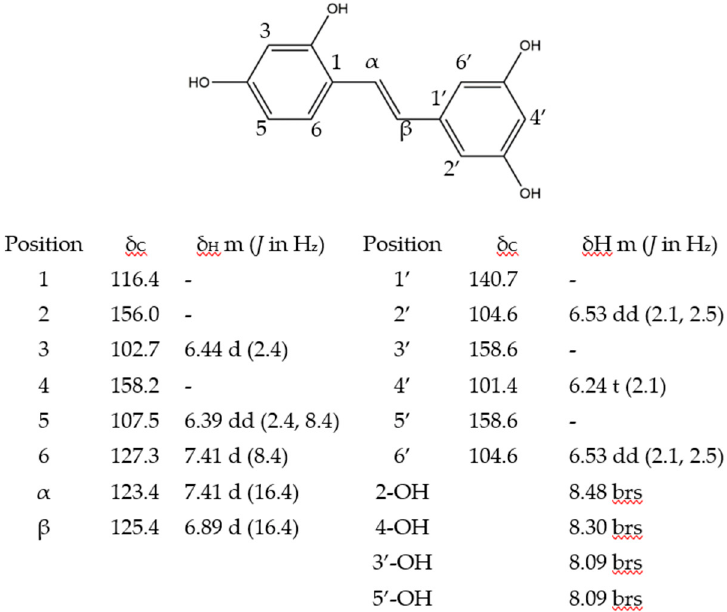
Figure 3. 13 C-NMR (300 MHz, Acetone-d 6 ) and 1 H-NMR (300 MHz, Acetone-d 6 ) data of oxyresveratrol .